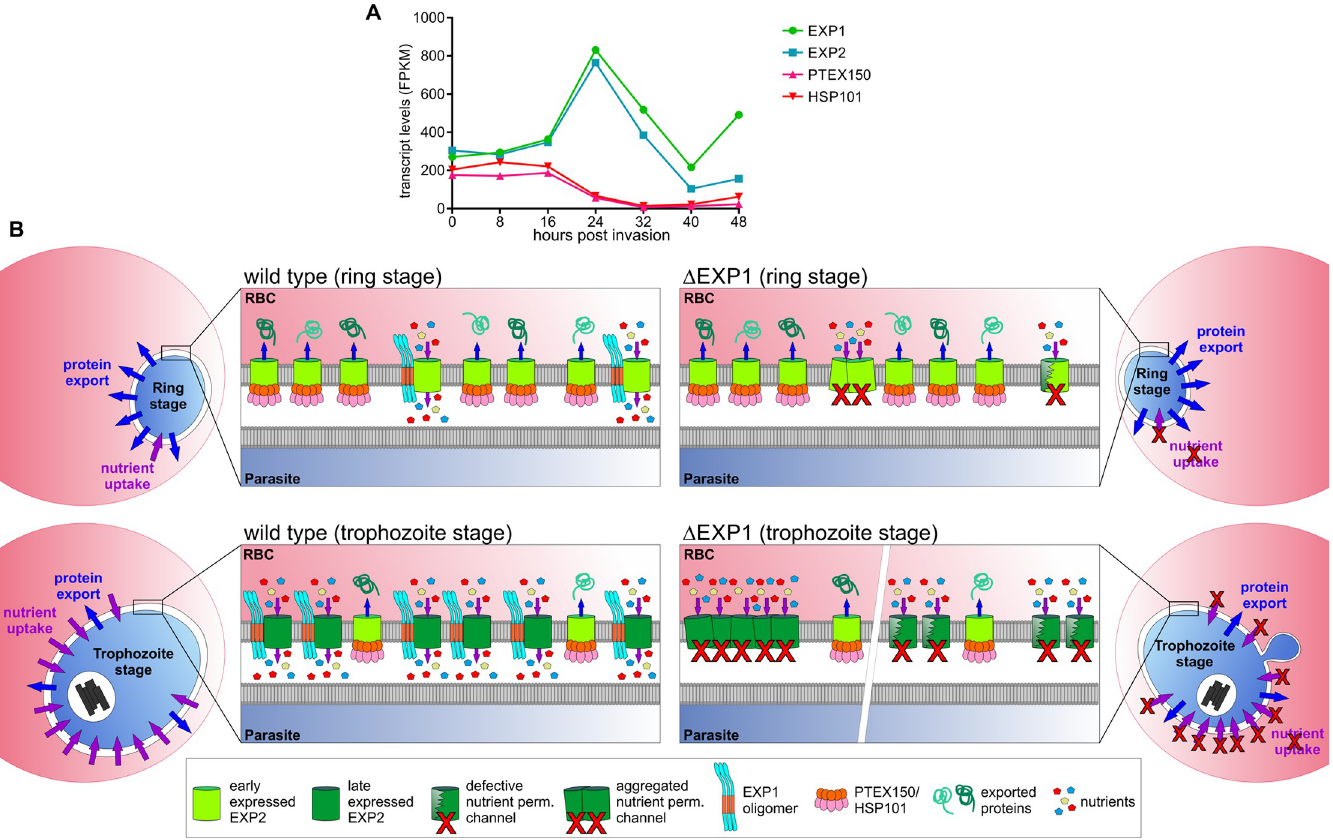
Fig 8. Model of the EXP1-defined nutrient-permeable channel function of EXP2 distinct from the PTEX complex. (A) Transcript levels of EXP1, EXP2, and the PTEX components HSP101 and PTEX150 across the asexual intra-erythrocytic cycle. Values were obtained from a previous publication [40]. (B) Schematics of the PVM of wild-type (left) and Δ EXP1 parasites (right) during the ring (upper panel) and trophozoite stage (lower panel). Depicted molecules are explained in the box. Note that early expressed EXP2 is in light green and late expressed EXP2 is in dark green. In wild-type rings, EXP2 is predominantly associated with PTEX components to promote protein export, a major function of this stage. Less EXP2 is in the nutrient-permeable channel complex that depends on EXP1 but does not contain other PTEX components. The proportion of the abundance of the two EXP2 complexes is reversed in the trophozoite stage when most of protein export has been completed but rapid parasite growth demands more nutrients. PTEX150 and HSP101 are not expressed in this stage, but PTEX translocons left over from the ring stage make up a minor proportion of EXP2 complexes to maintain protein export activity. The nutrient-permeable channel function of EXP2 is negatively affected by loss of EXP1 either through indirect effects (indicated as aggregated EXP2, left part of PVM enlargement of Δ EXP1 KO) or a direct defect of the complex (“defective” nutrient-permeable channel, right part of Δ EXP1 KO). EXP1, exported protein 1; FPKM, fragments per kilobase of exon model per million mapped reads; h.p.i., hours post invasion; HSP101, heat shock protein 101; KO, knockout; PTEX, Plasmodium translocon of exported proteins; PVM, parasitophorous vacuolar